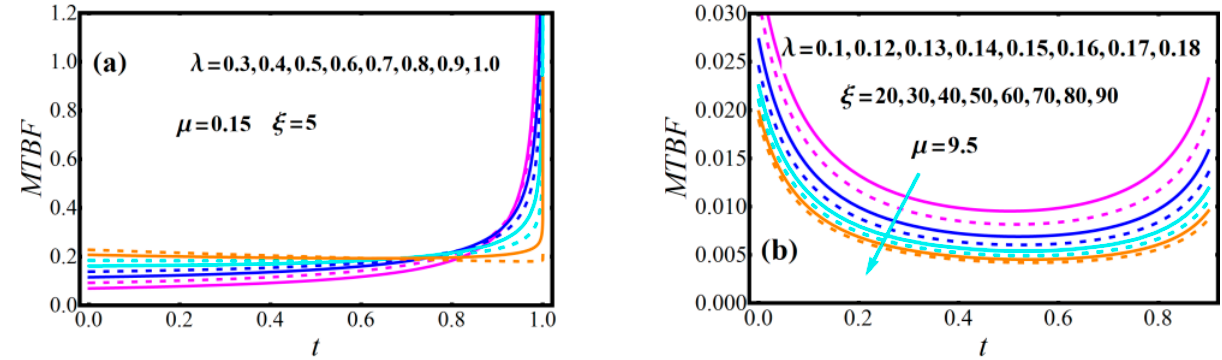
Figure 5. Plots of the MTBF function of the NHPP–NPF model.